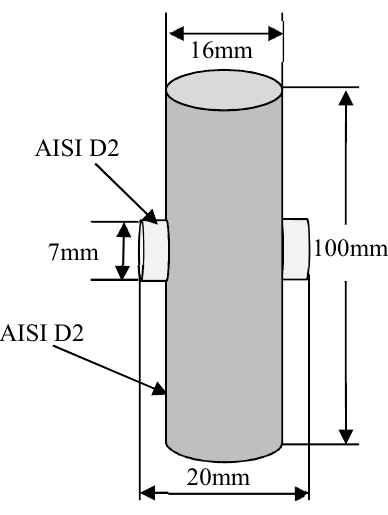
Figure 1. Schematic drawing of the AISI D2 parts combination.